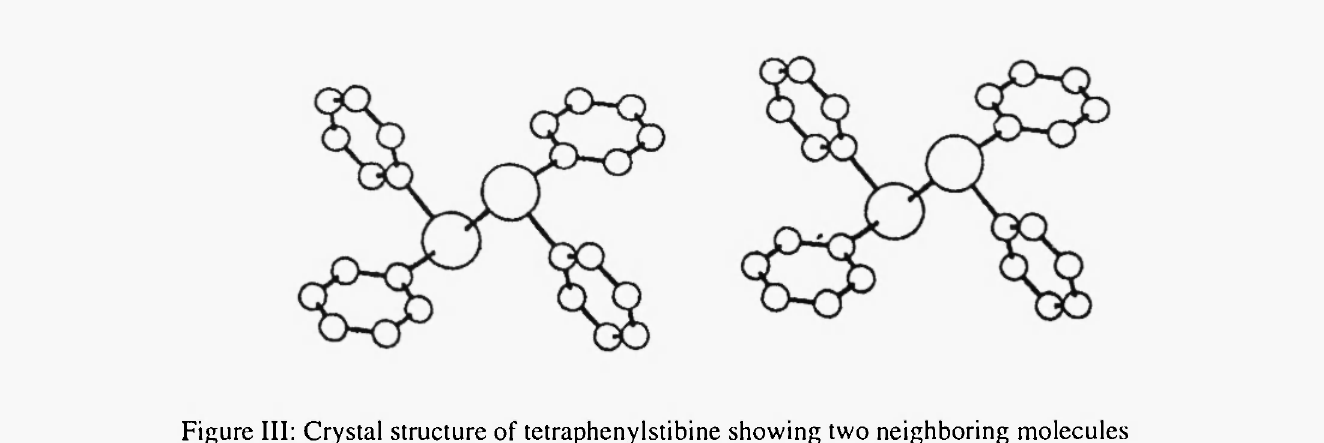
Figure III: Crystal structure of tetraphenylstibine showing two neighboring molecules reproduced from ref. (12) with permission